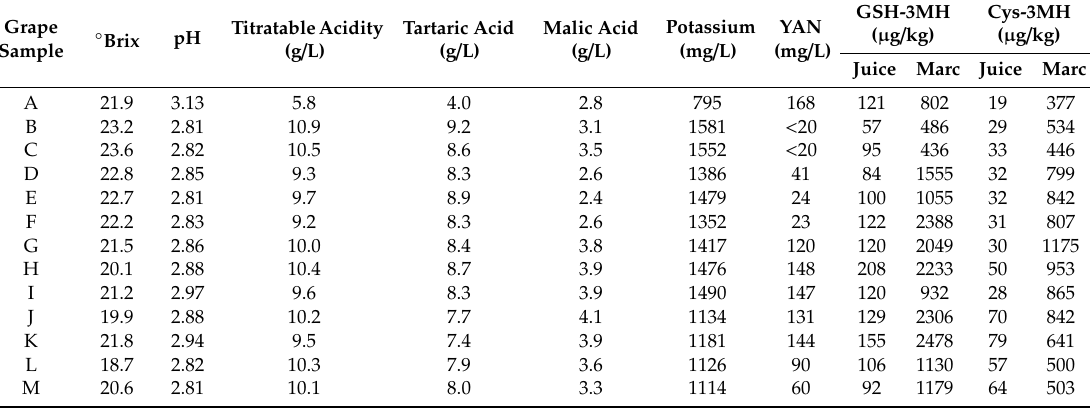
Table 1. Quality control parameters and concentration of thiol precursors of Sauvignon Blanc grape samples ( n = 13) of the semi-industrial